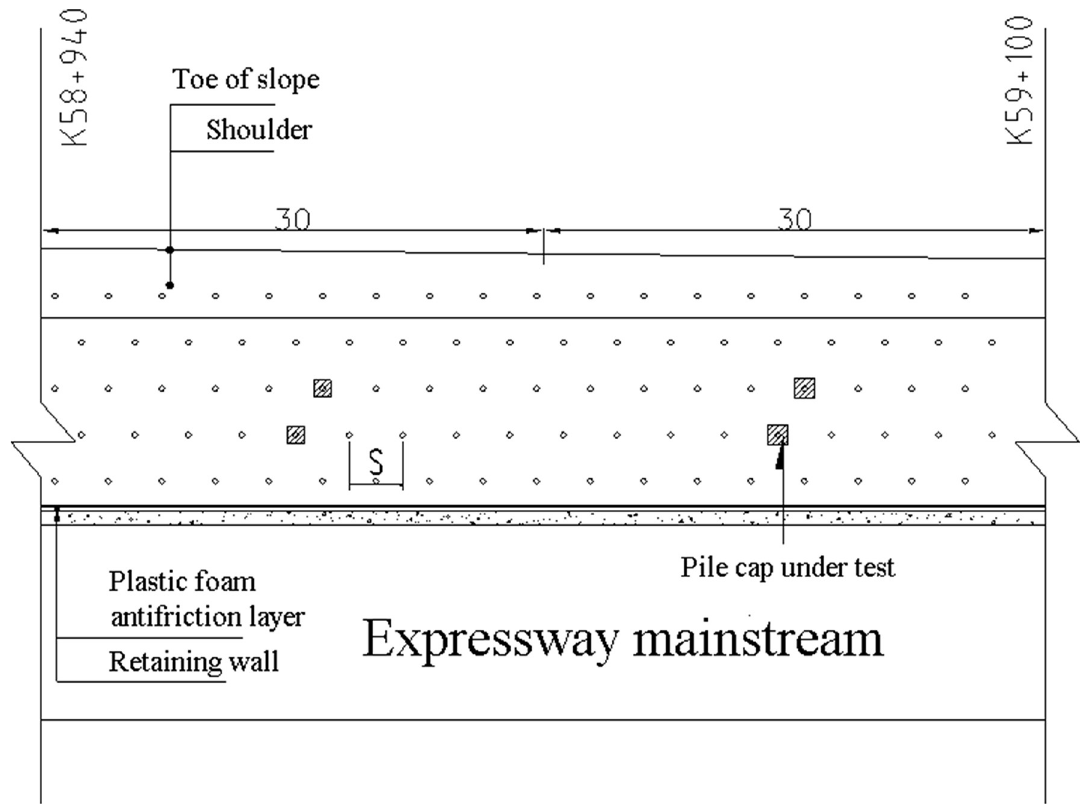
Fig 5. Embankment construction plan for Section A2 of the